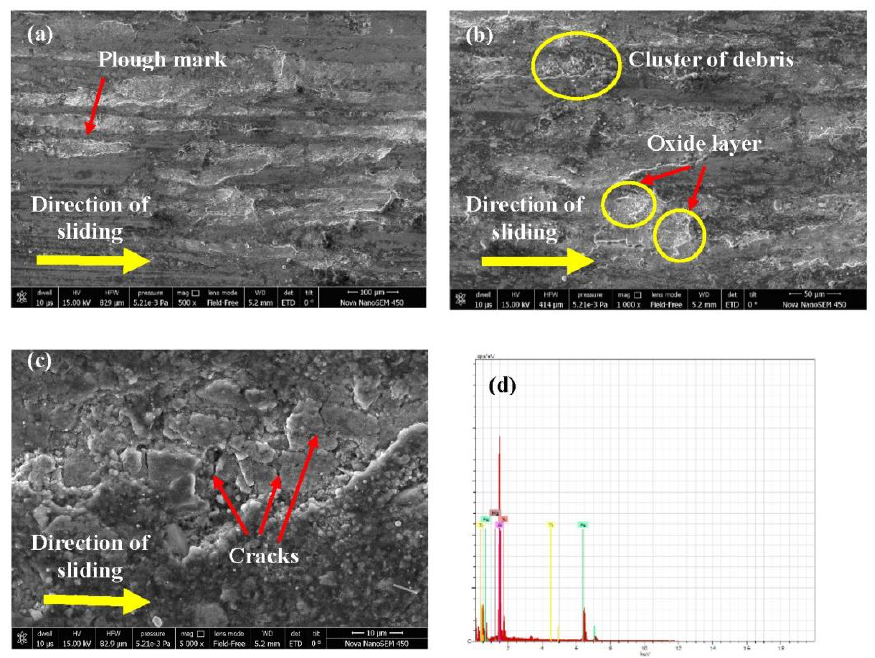
Fig. 11. (a), (b), (c) FESEM images of Al-Si-Mg/TiB 2 composites at 9 h ageing time, 2 m/s sliding speed and 24.52 N, (d) EDS mapping of Al-Si-Mg/TiB 2 composites at 9 h ageing time, 2 m/s sliding speed and 24.52